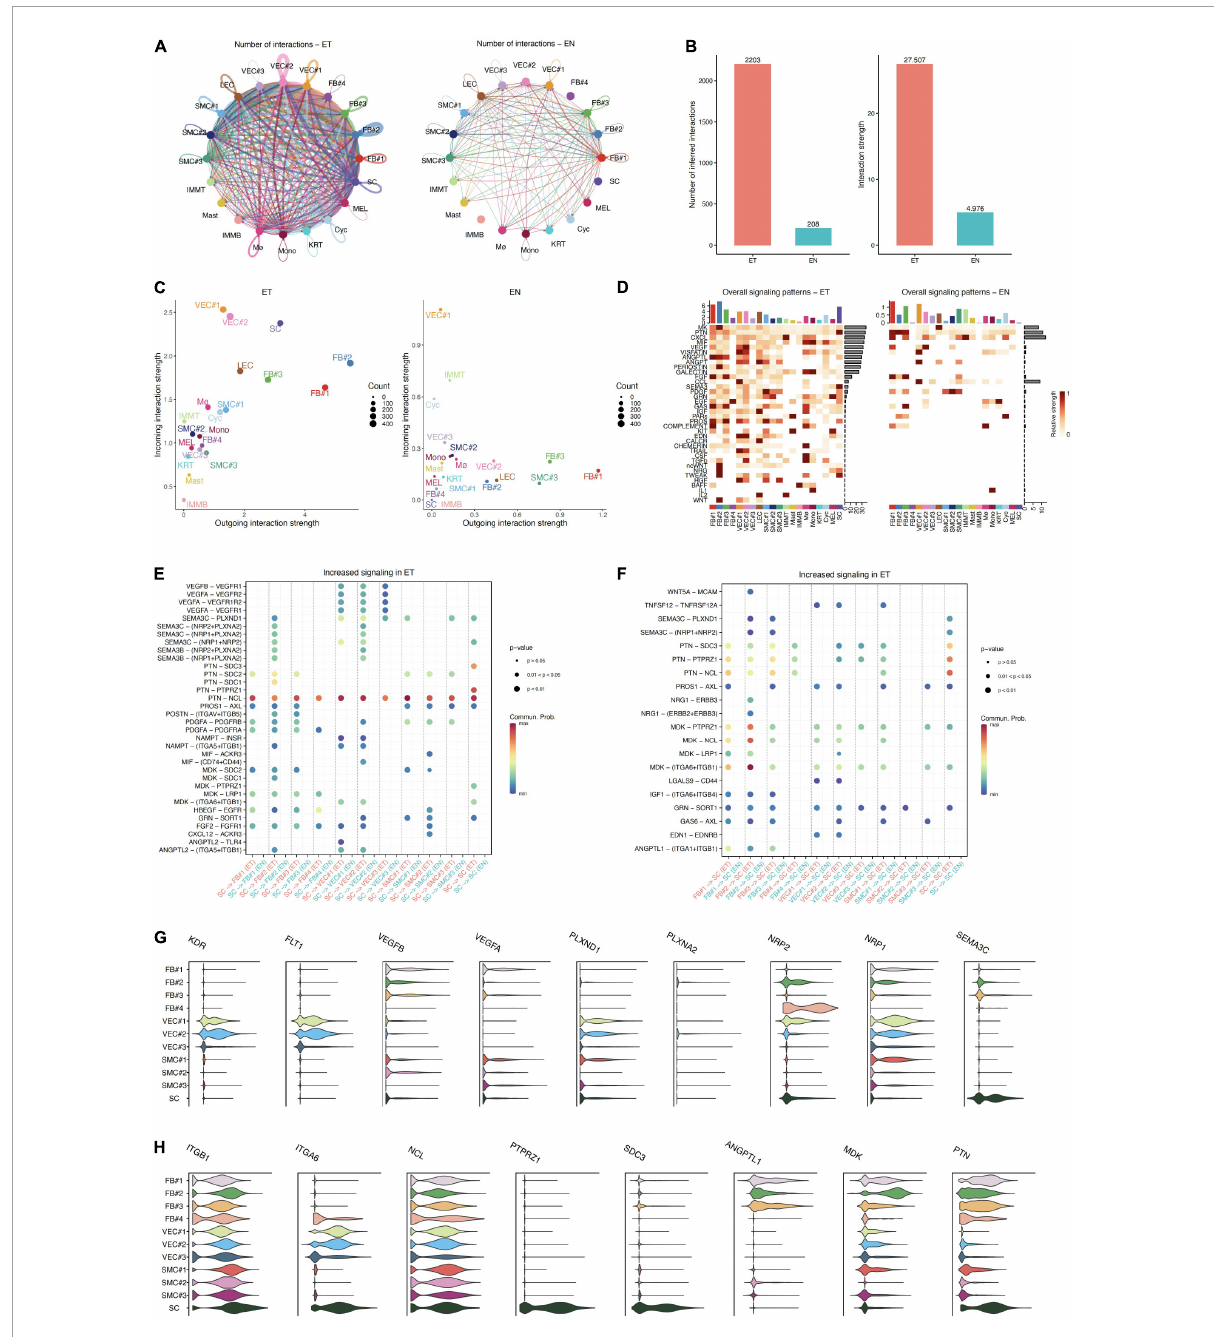
FIGURE4 Intercellular communication in normal skin and keloid samples. (A) Circos plots show the interactions density between any two cell types in earlobe keloid samples (ET) and normal skin (EN), respectively. (B) Bar plots show the number of intercellular communication (left) and interaction strength (right) in earlobe keloid samples (ET) and normal skin (EN), respectively. (C) Comparing the outgoing and incoming interaction strength in 2D space by scatter plots to allow identifying the cell populations with significant changes in sending or receiving signals in earlobe keloid samples (ET) and normal skin (EN), respectively. (D) The heatmap showed all signaling patterns and the strength of each cell type and subpopulation in earlobe keloid samples (ET) and normal skin (EN), respectively. (E) The significant ligand–receptor pairs between ECM-related subpopulations and SC in earlobe keloid samples (ET) and normal skin (EN). Here, SC were as sources and ECM-related subpopulations were as targets. P -value < 0.05 was considered significant interactions. (F) The significant ligand–receptor pairs between ECM-related subpopulations and SC in earlobe keloid samples (ET) and normal skin (EN). Here, ECM subpopulations were as sources and SC were as targets. P -value < 0.05 was considered significant interactions. (G) Violin plots showed gene expression level of specific genes in ligand–receptor pairs in ECM-related subpopulations and SC, including SEMA3C and its consistent receptors. (H) Violin plots showed gene expression level of specific genes in ligand–receptor pairs in ECM-related subpopulations and SC, including PTN, MDK, and their consistent